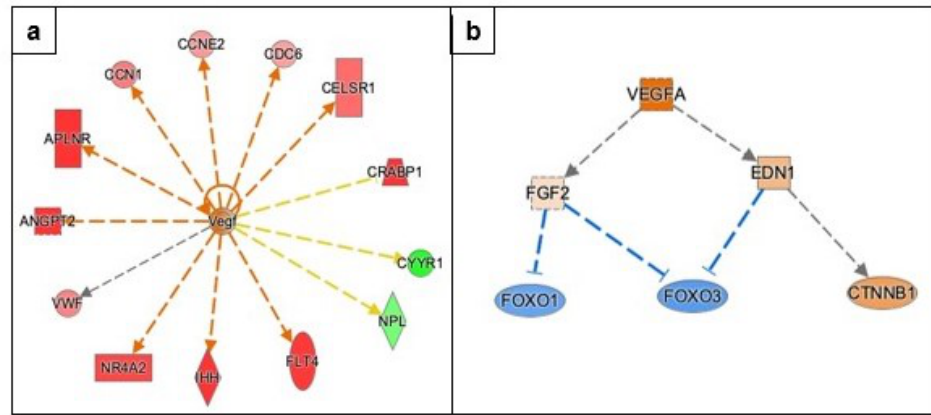
Figure 6. Effect of metformin on angiogenesis as predicted by IPA. ( a ) Transcription factor VEGF involved in angiogenesis is predicted to be activated through the upregulation of molecules in the dataset. ( b ) VEGFA network, the top mechanistic network to be activated acting through FGF2, EDN1, FOXO1, FOXO3, and CTNNB1 regulators. The key for the shape, color, direction and molecule types in the above pathways is provided in Figure 4.